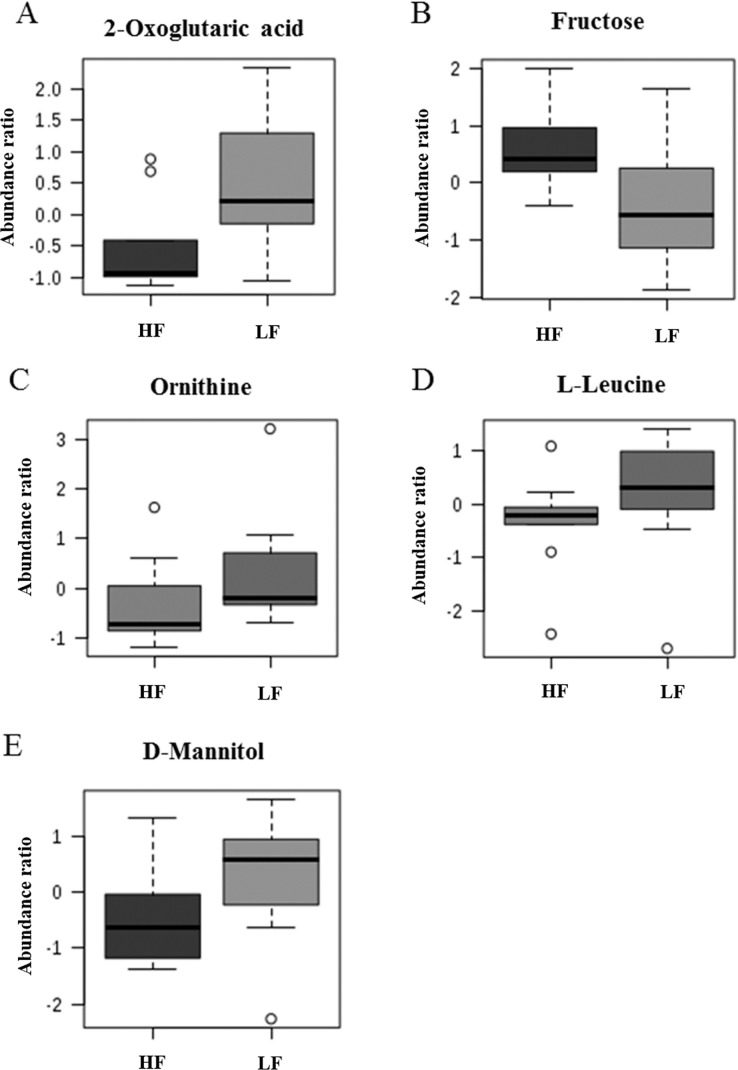
Box plots of the abundance ratio of five metabolites in high and low fertility bulls.(A) 2-oxoglutaric acid, (B) fructose, (C) ornithine, (D) L-leucine and (E) D-mannitol were significantly different (P ≤ 0.05) between high (HF) and low (LF) bulls.